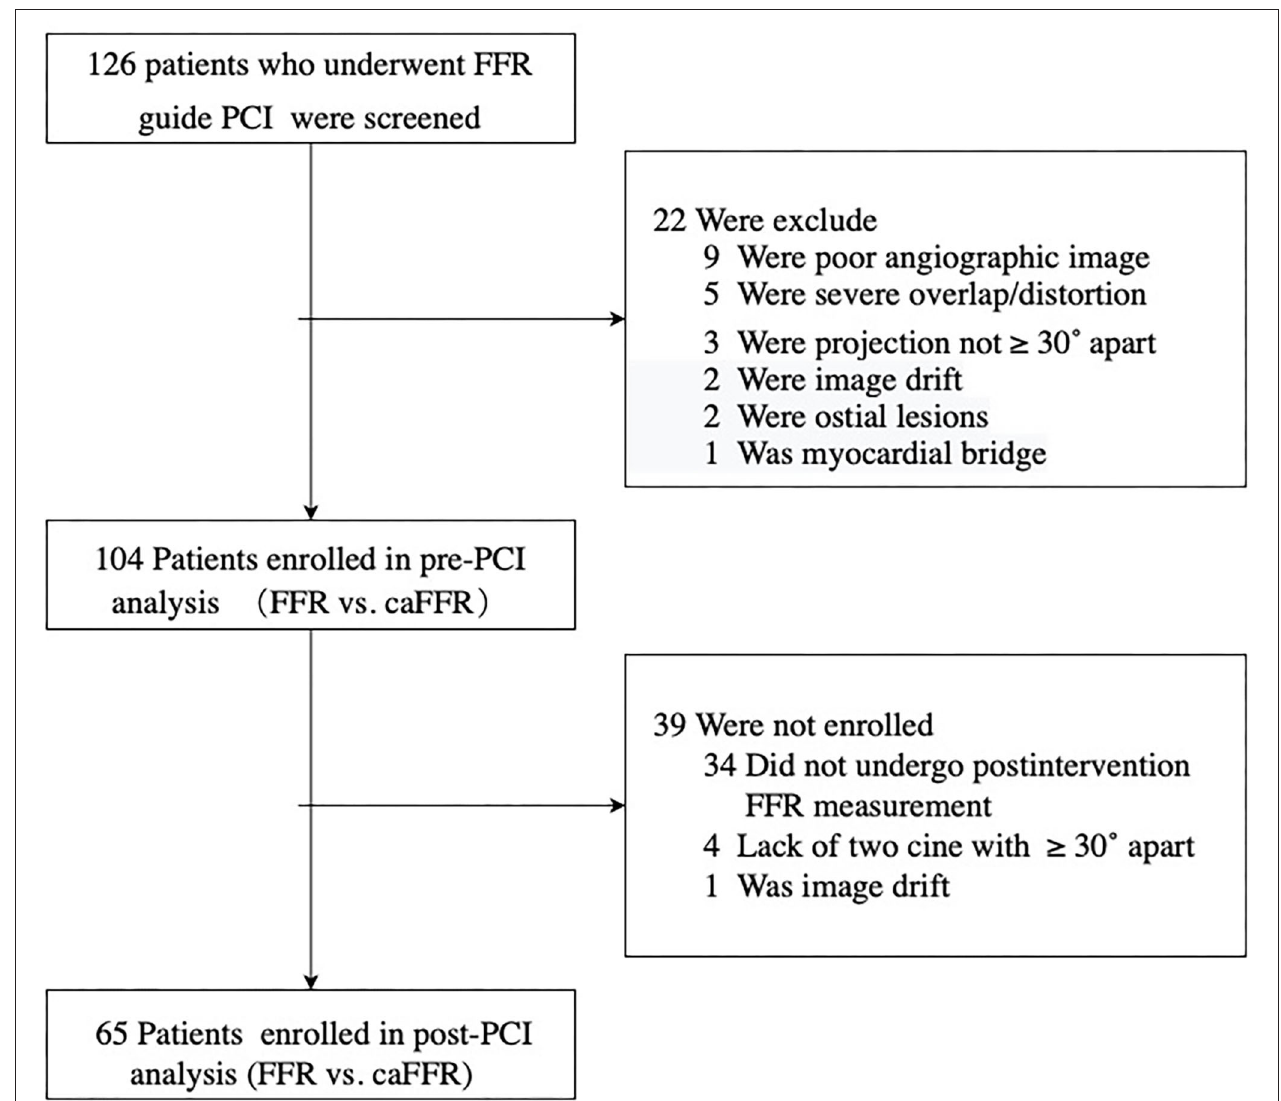
FIGURE 2 | Study flow diagram. SIHD, stable ischemic heart disease; LAD, left descending artery; FFR, fractional flow reserve; PCI, percutaneous coronary intervention; caFFR, coronary angiography-derived